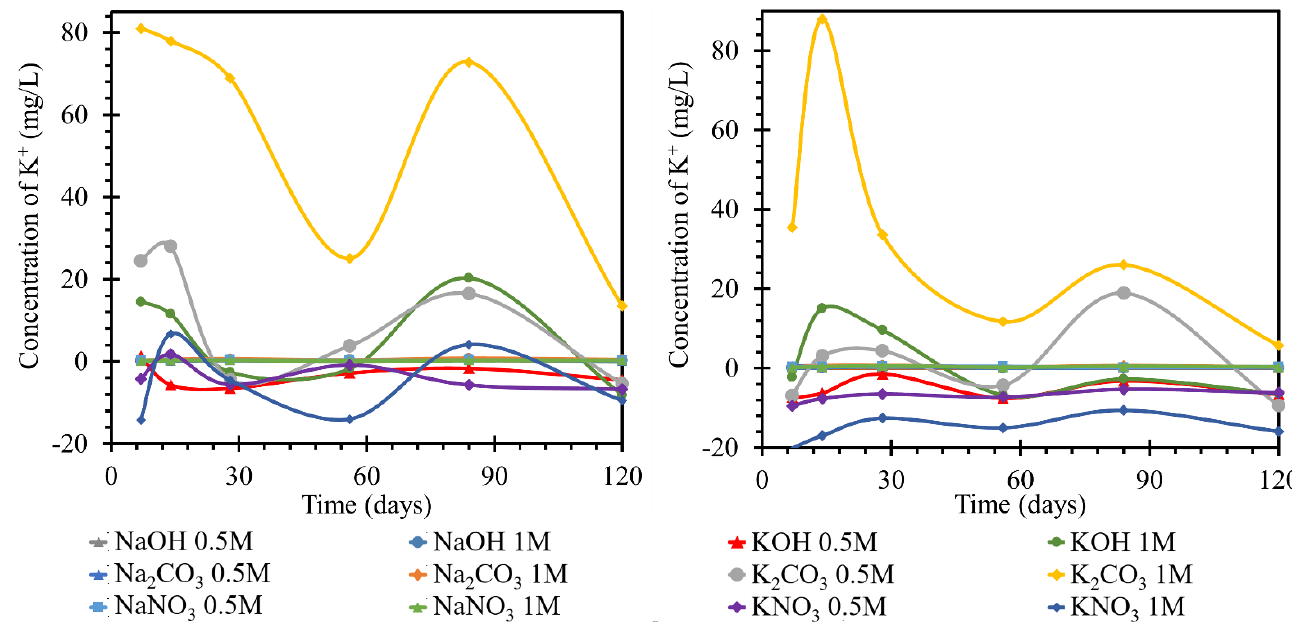
Figure 6. Results of monitoring potassium ion concentrations in individual solutions, on the left at the laboratory temperature of 25 °C, on the right at 40 °C. The K + concentrations were determined using the ICP − OES method; for clarity, the error bars are not shown, but they reach 1.85% maximum. For the evaluation of the sodium ion evolution, if a catex effect occurred, there would have to be sodium evolution and potassium loss in the same solution (or vice